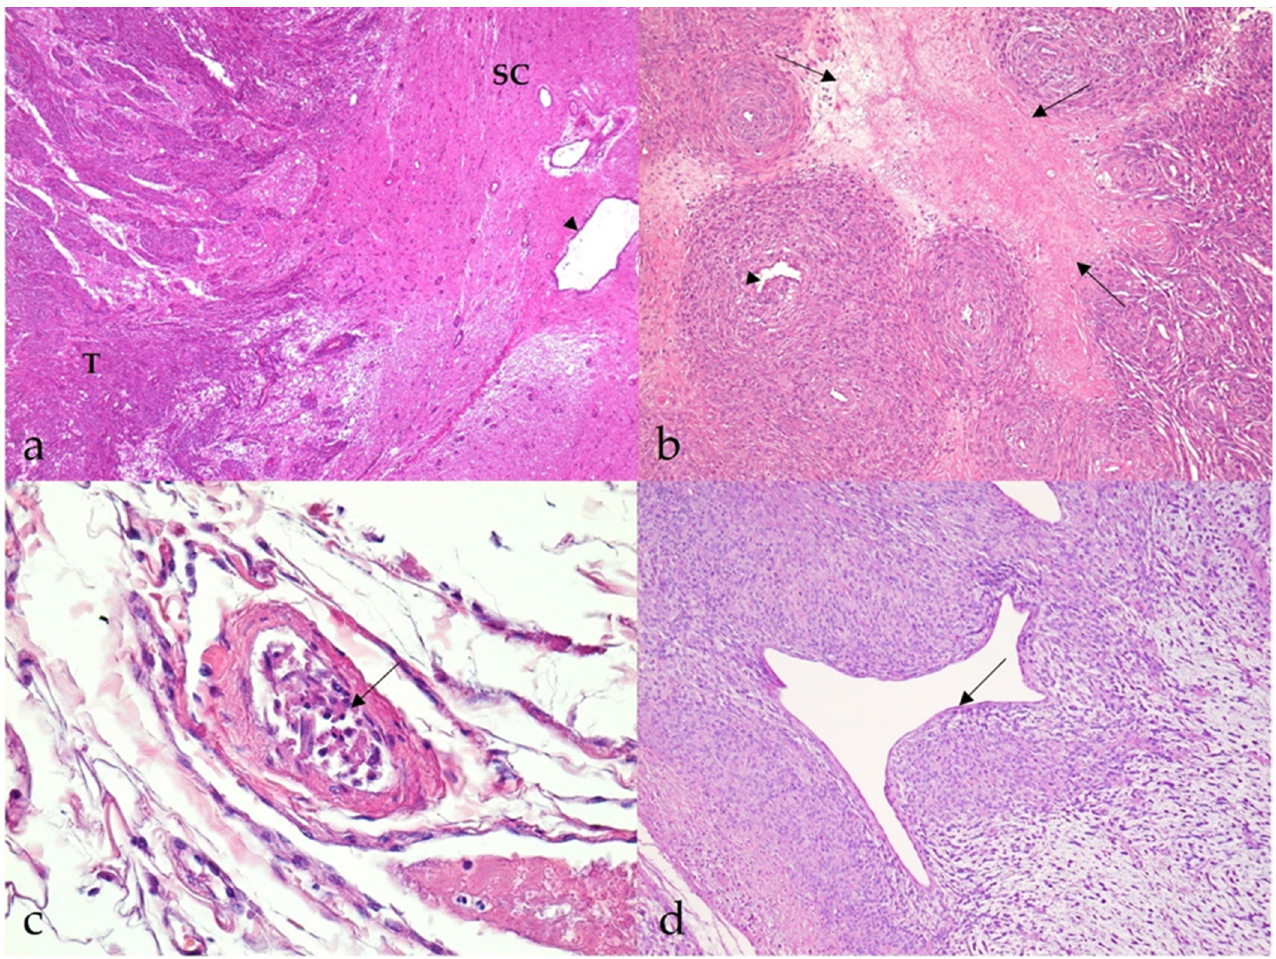
Figure 3. Histopathological characteristics of malignant nerve sheath tumors (MNSTs). ( a ) Marked infiltrative growth of high-cellular MNST into the spinal cord (case no. 51). T: tumor; SC: spinal cord; arrowhead: spinal cord canal. HE, 40×. ( b ) Well demarcated geographical necrosis (arrows). Slight intraluminal vascular herniation (arrowhead) is seen (case no. 69). HE, 100×. ( c ) Numerous spindloid cells in the lumen of a blood vessel, indicating blood vessel invasion (arrow) (case no. 60). HE, 400×. ( d ) Perivascular hypercellularity with distinct herniation of the tumor into the vessels (arrow) (case no. 65). HE, 100×.